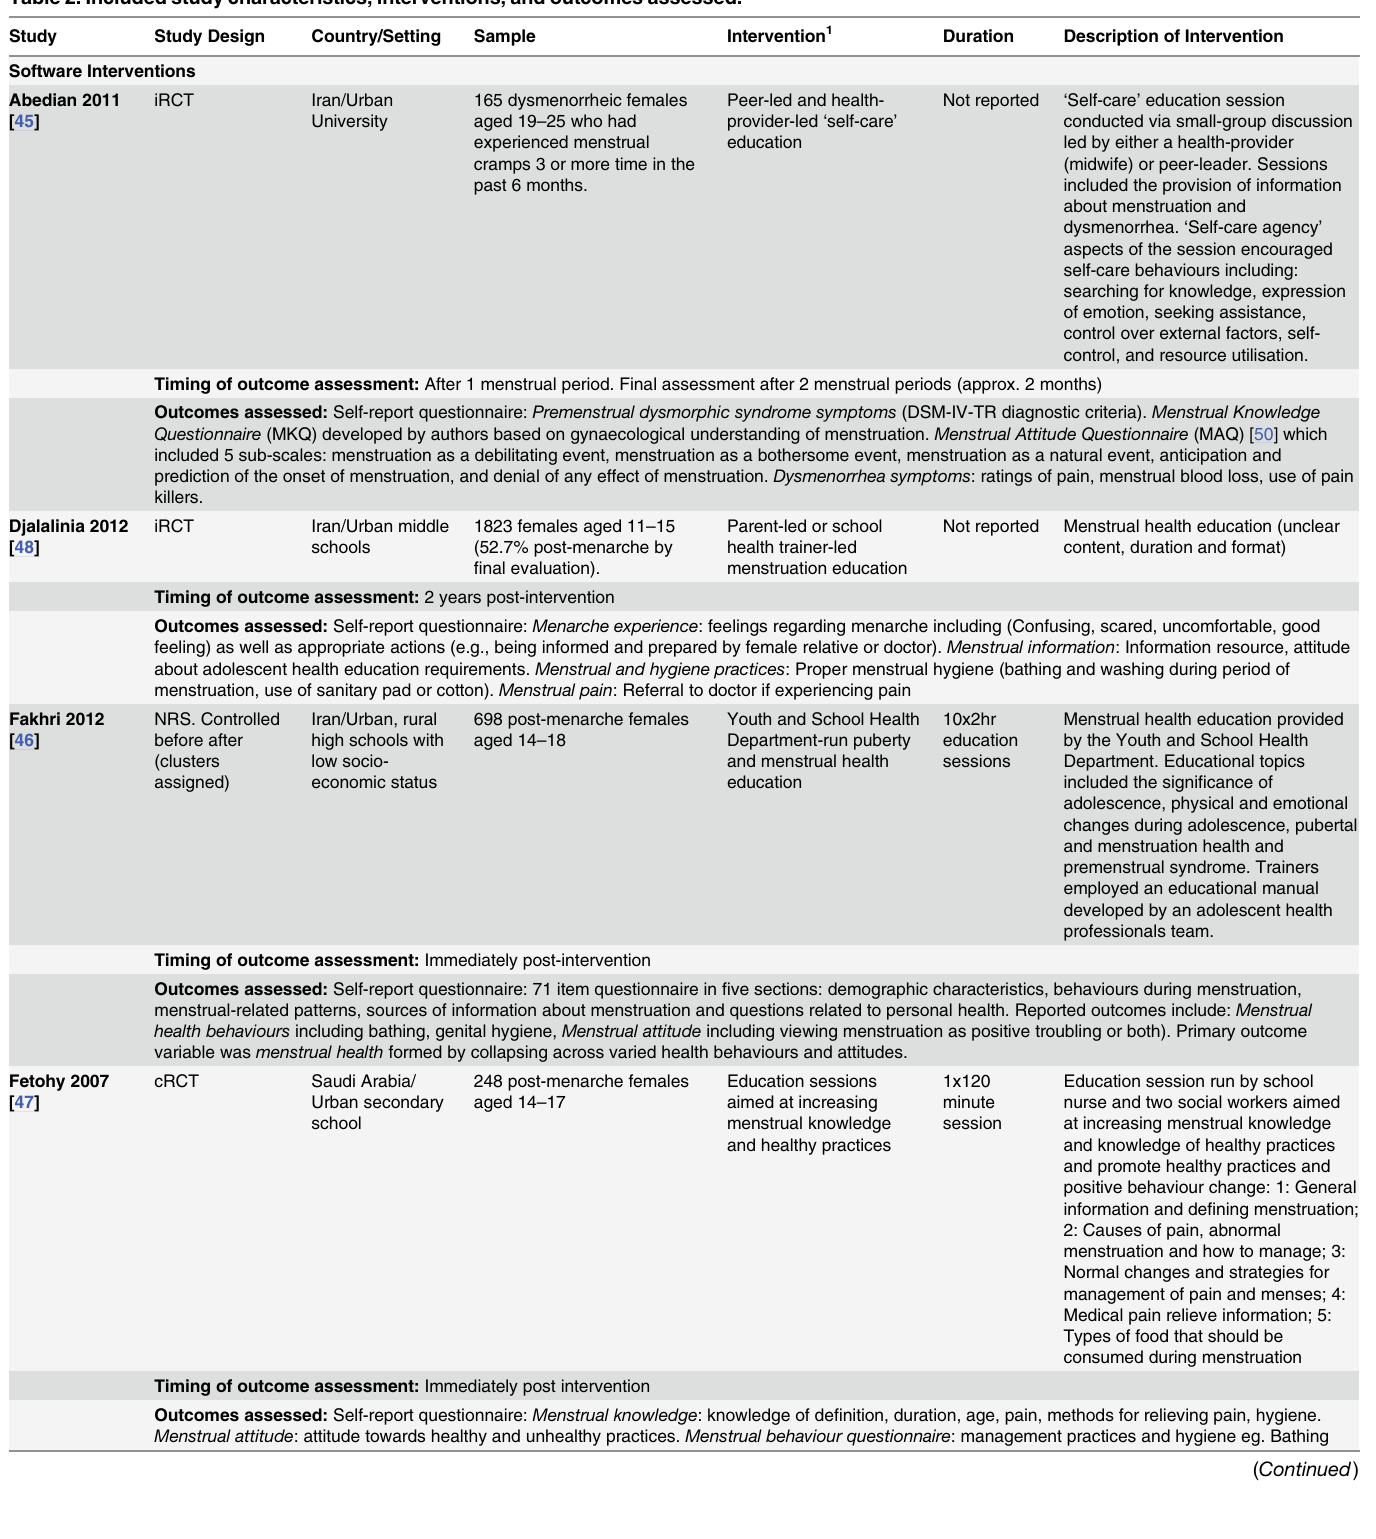
Table 2. Included study characteristics, interventions, and outcomes